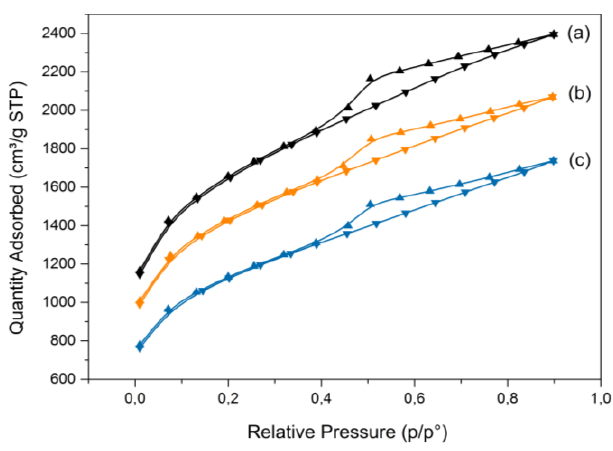
Figure 5. N 2 adsorption–desorption isotherm of PAC ( a ), Fe 3 O 4 -PAC ( b ), and Cu-Fe 3 O 4 -PAC ( c ).